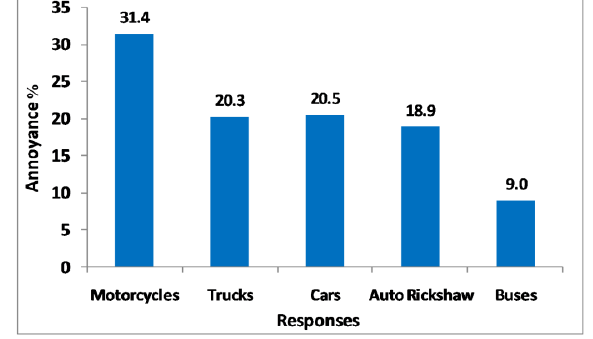
Figure 7. Annoyance associated with different type of vehicles